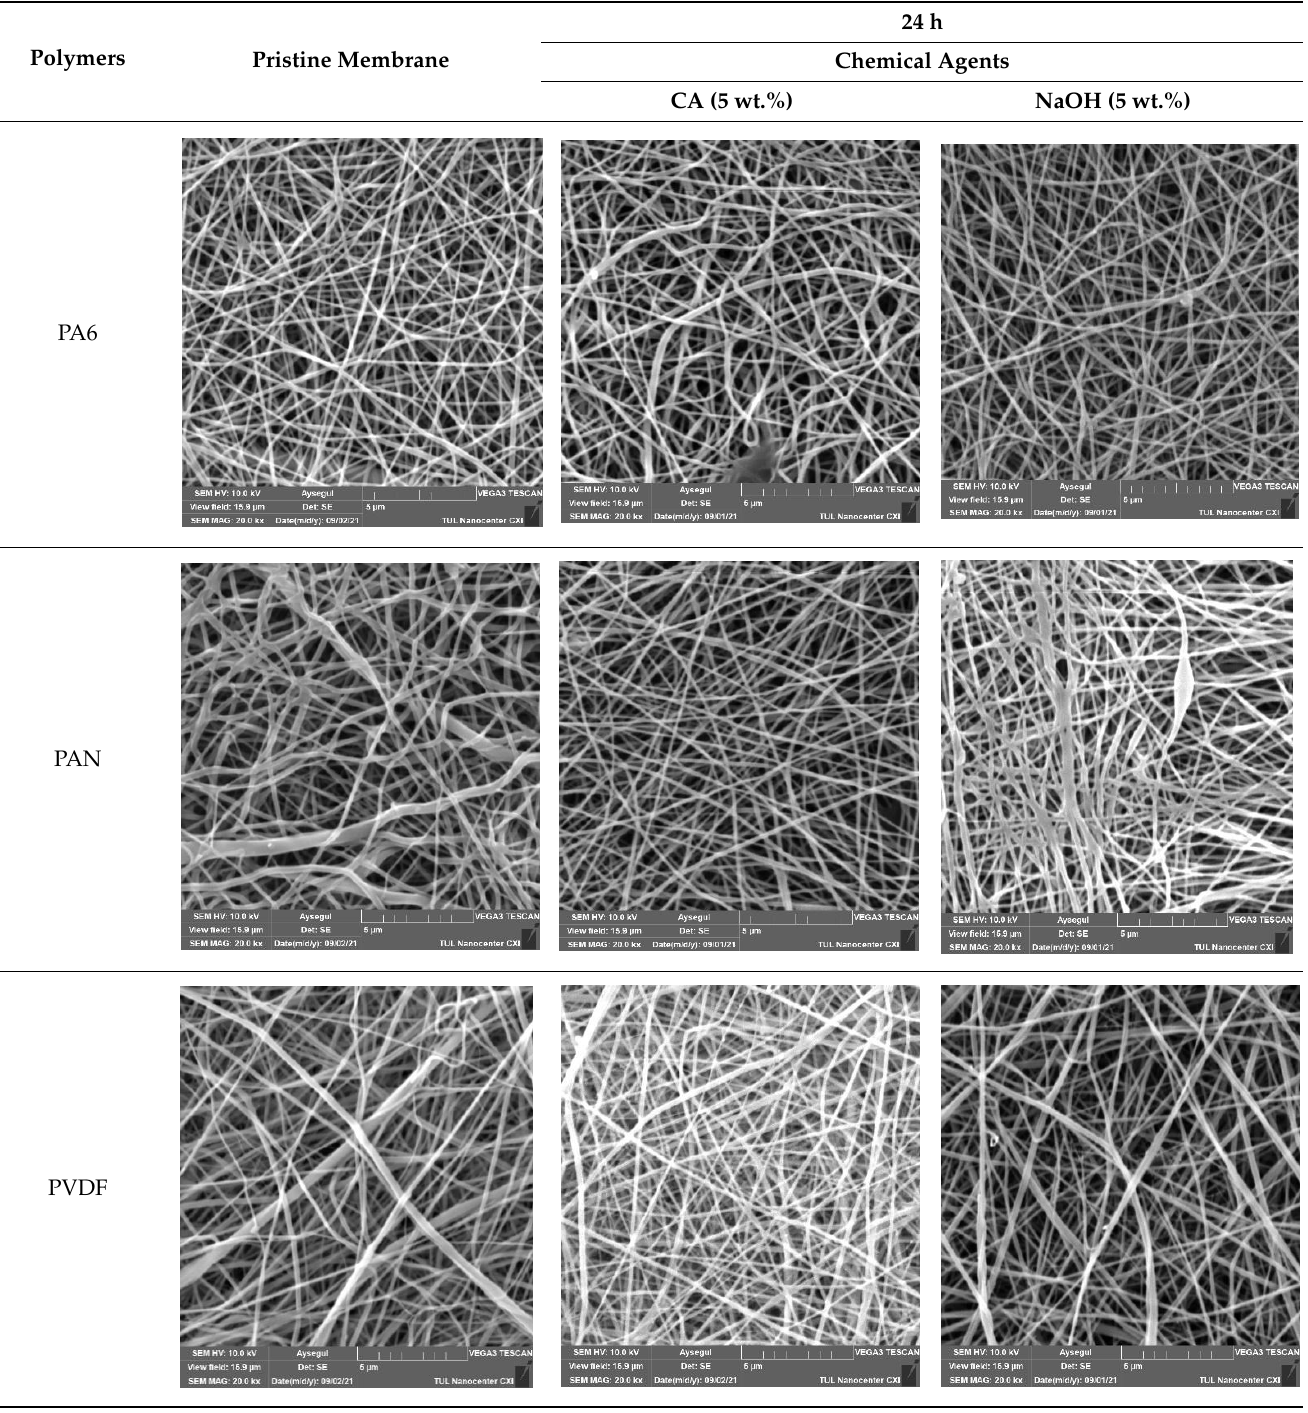
Table 6. SEM images of membranes after the application of chemical cleaning agents (5% CA-5% NaOH).